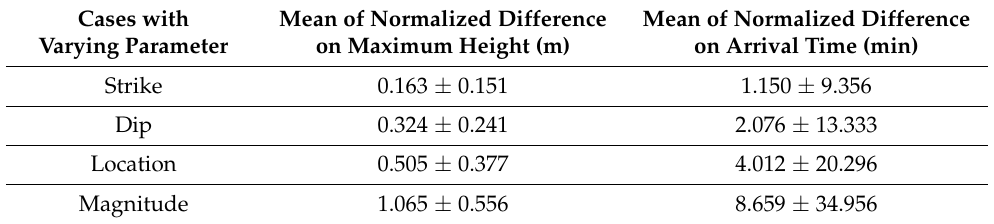
Table 3. Mean of normalized greatest maximum height differences and of normalized arrival time differences for all FCPs and cases varying one of the four source